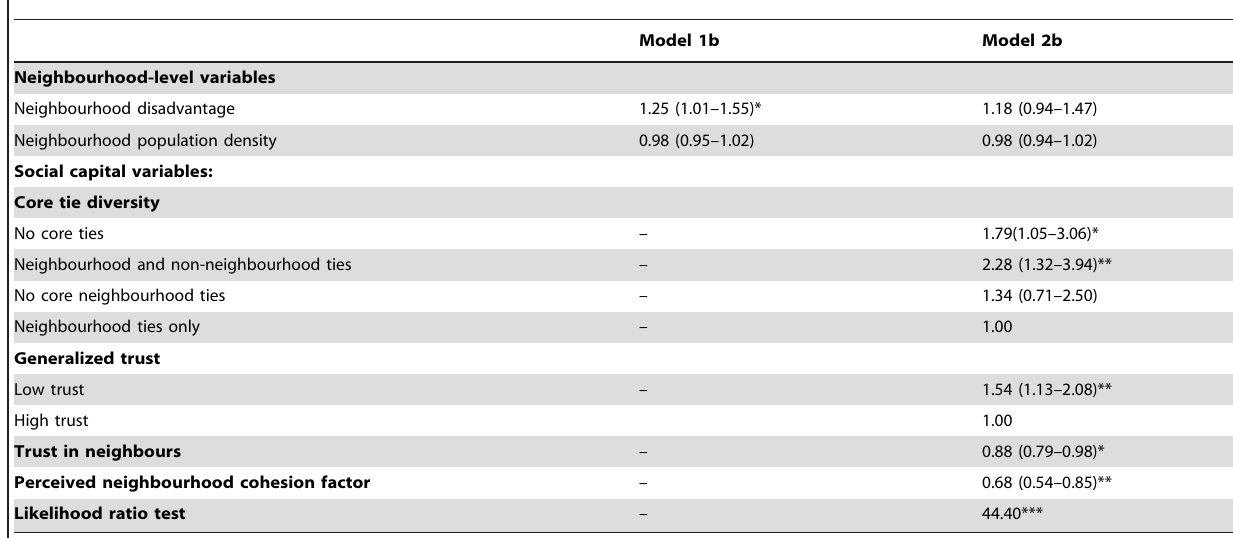
Table 2. Adjusted odds ratio and 95% confidence intervals from multilevel logistic regression analyses, MoNNET-HA Women, n= 1662 (controlling for socio-demographic